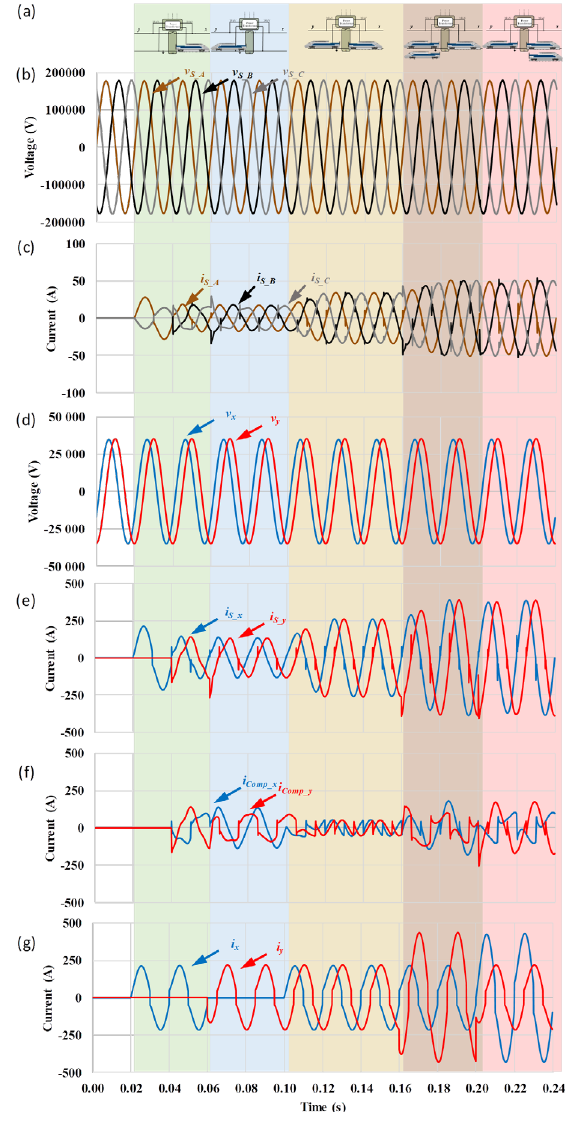
Figure 11. Simulation results of the RPC compensating the power quality problems